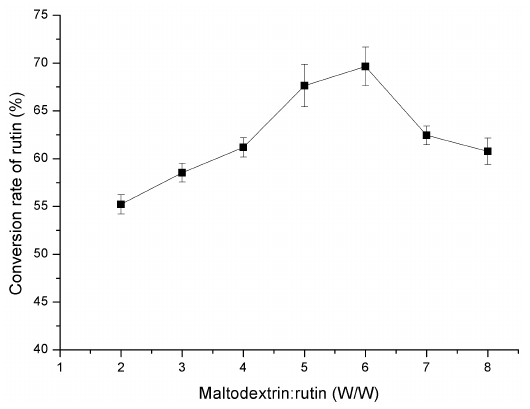
Figure 4. Effect of maltodextrin ratio to rutin (w/w) on rutin transglycosylation in the MAR system.